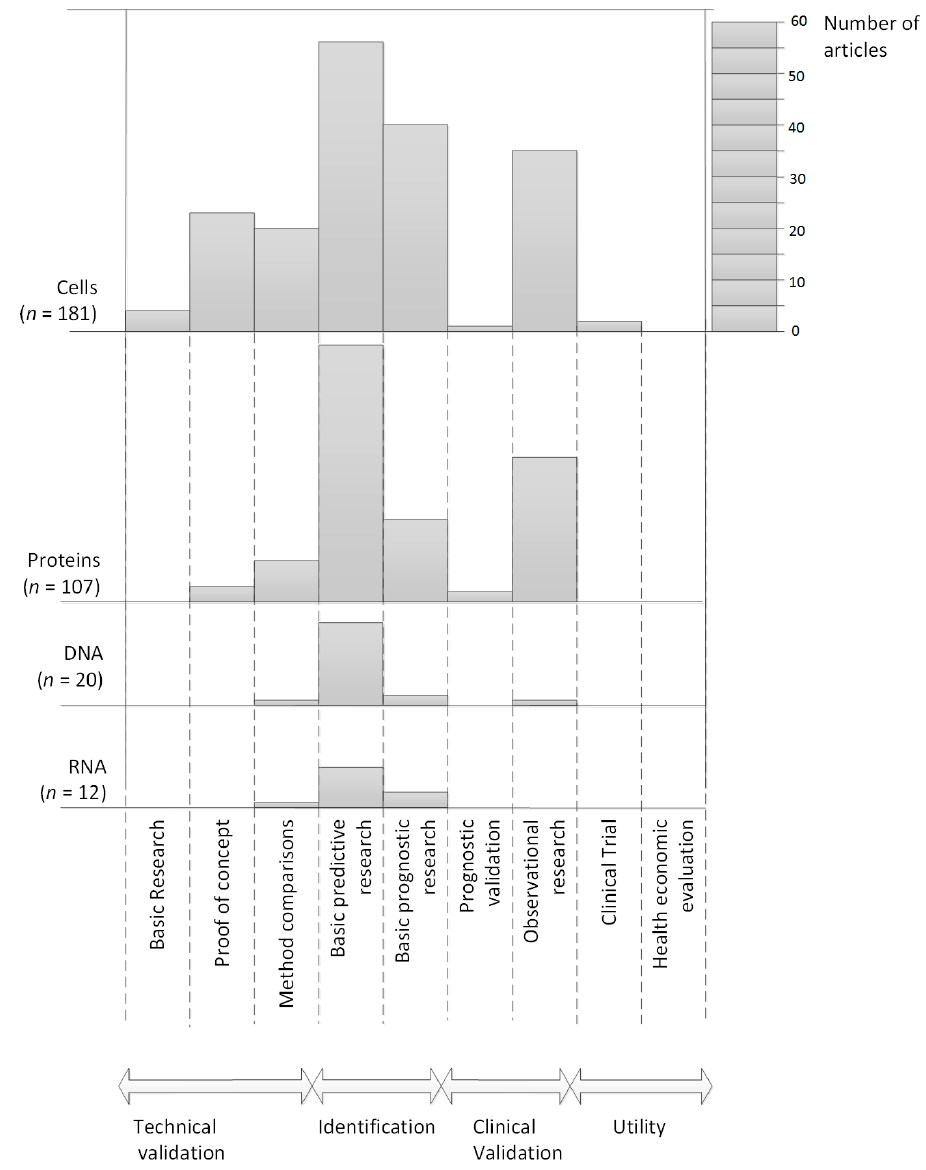
Figure 3. Development, Evaluation and Application Chart.